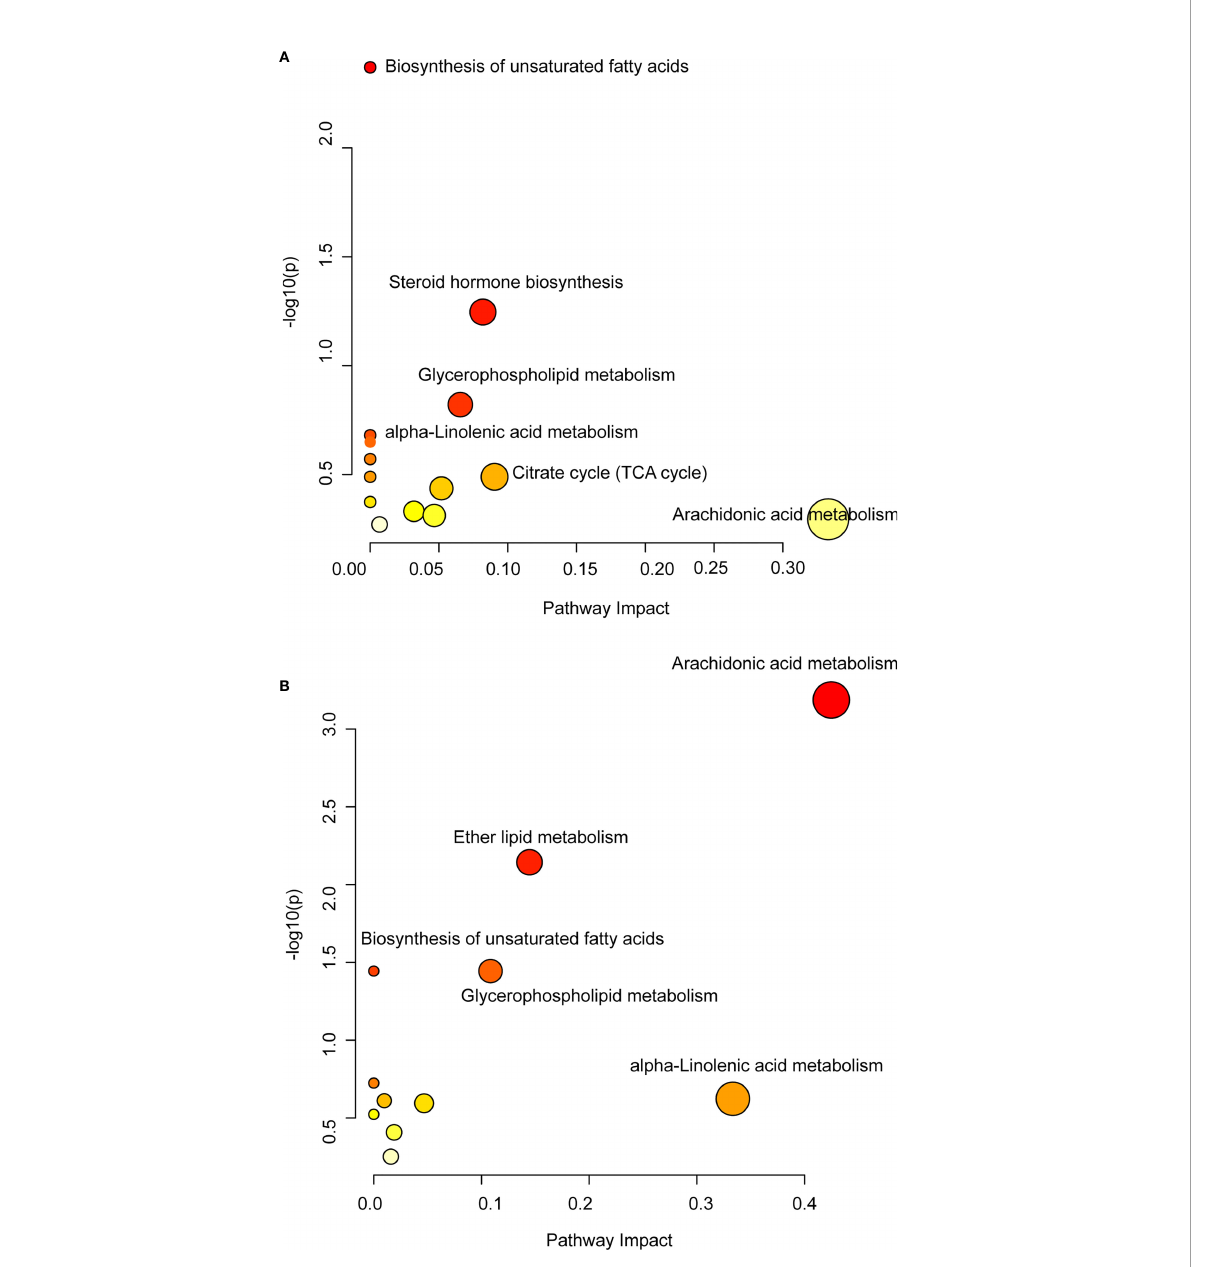
FIGURE 5 Differential metabolic pathways of DMs. (A) Metabolic pathway changes induced by QFPDD (QFPDD vs. Mod) in the lung tissue. (B) Metabolic pathway changes induced by QFPDD (QFPDD vs. Mod) in the